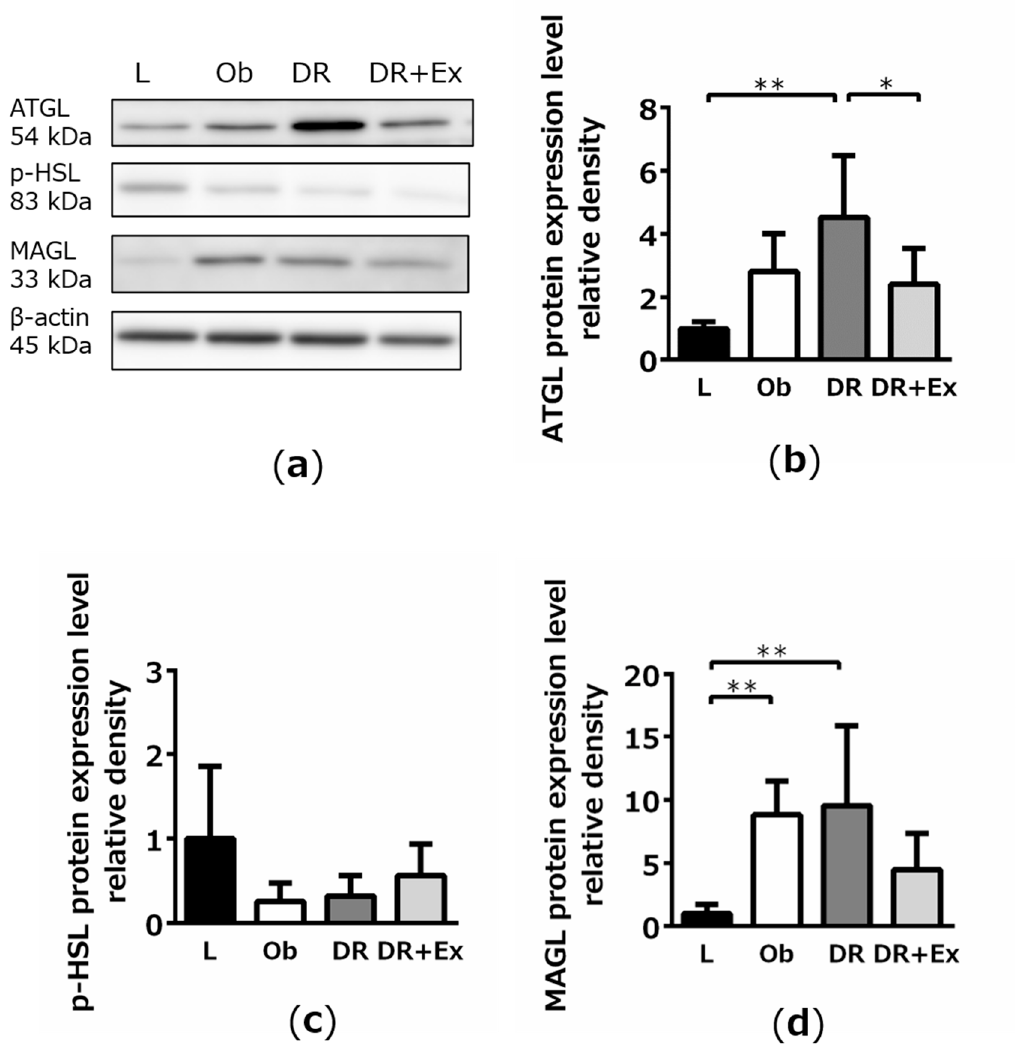
Figure 3. Western blotting results for the analysis of adipose triglyceride lipase (ATGL) ( b ), phosphorylated hormone- sensitive lipase (p-HSL) ( c ), and monoacylglycerol lipase (MAGL) ( d ) protein expression in lean control (L), obese (Ob), dietary restriction (DR), and dietary restriction plus exercise (DR + Ex) groups. Band images are shown in ( a ). β -Actin was used for normalization. Results are representative of three independent experiments and are shown as values relative to those in the L group, which were set to 1. Values are means ± SDs ( n = 6 rats in each group). * p < 0.05, ** p < 0.01.